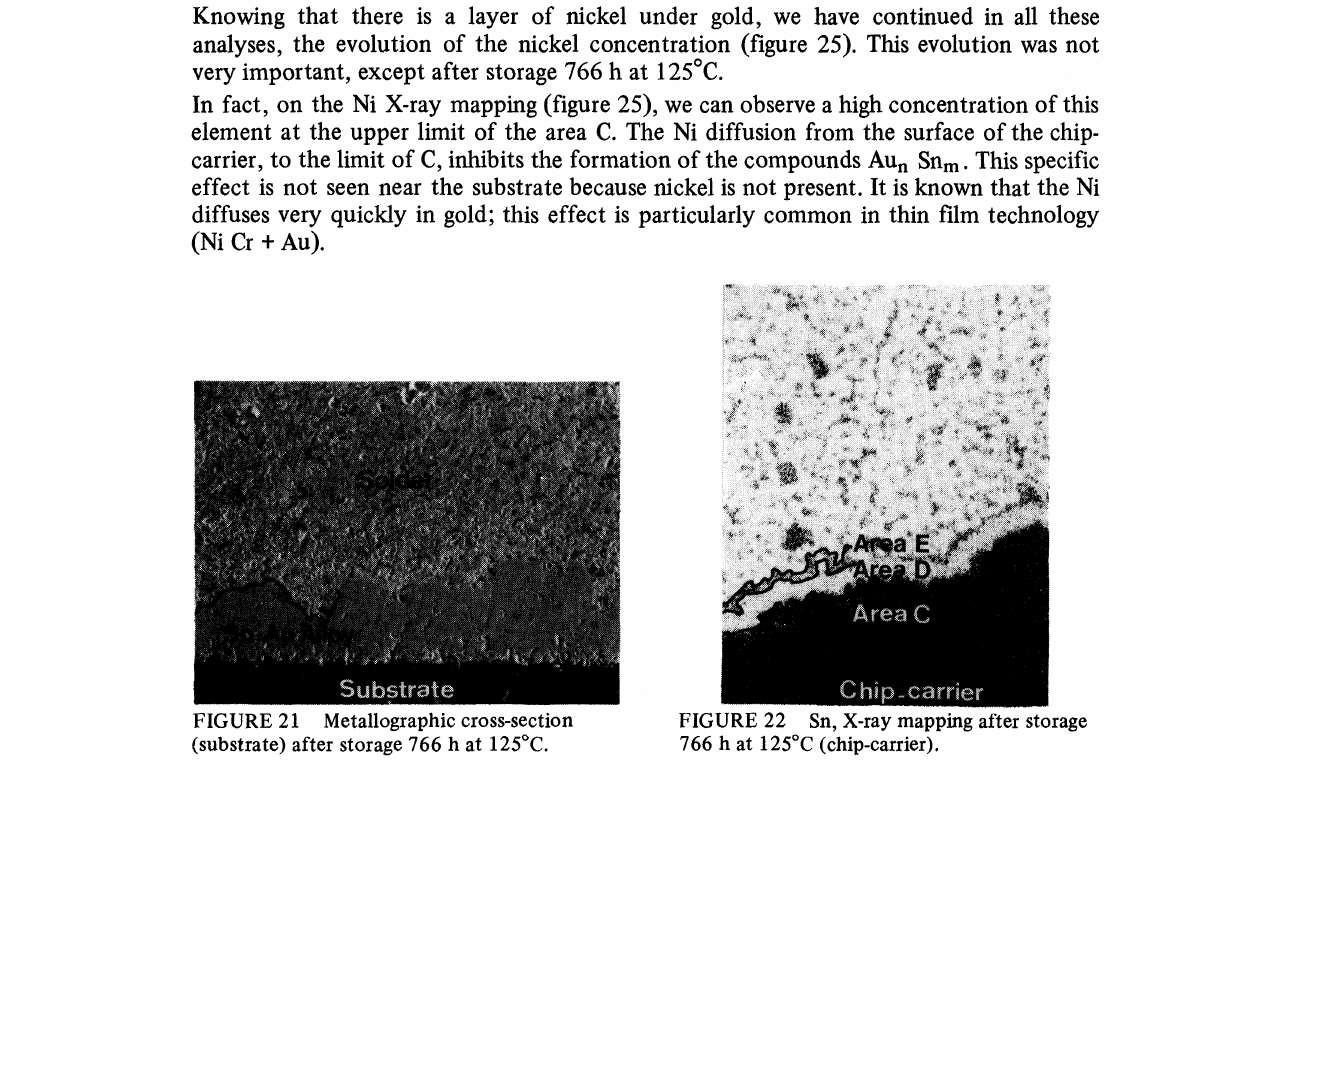
FIGURE 21 Metallographic cross-section (substrate) after storage 766 h at 125C.